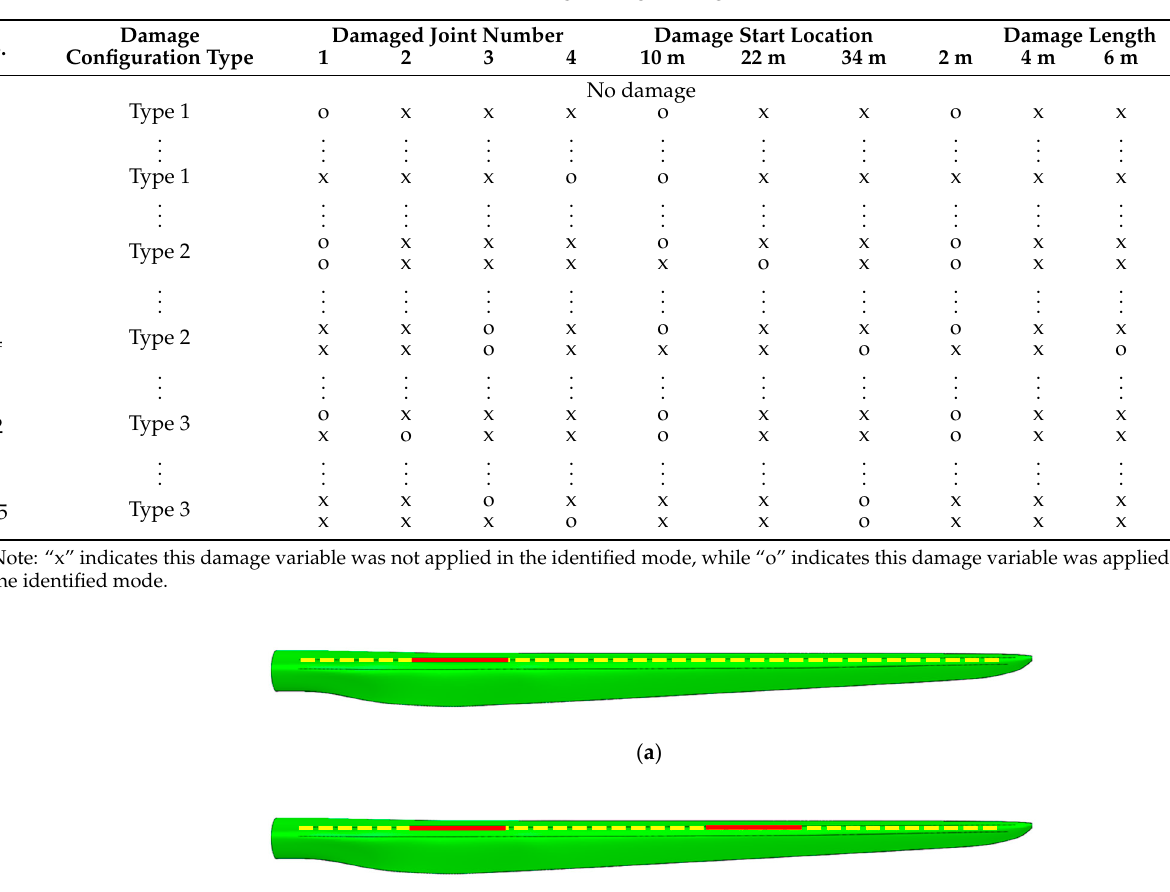
Table 2. Debonding damage configuration.